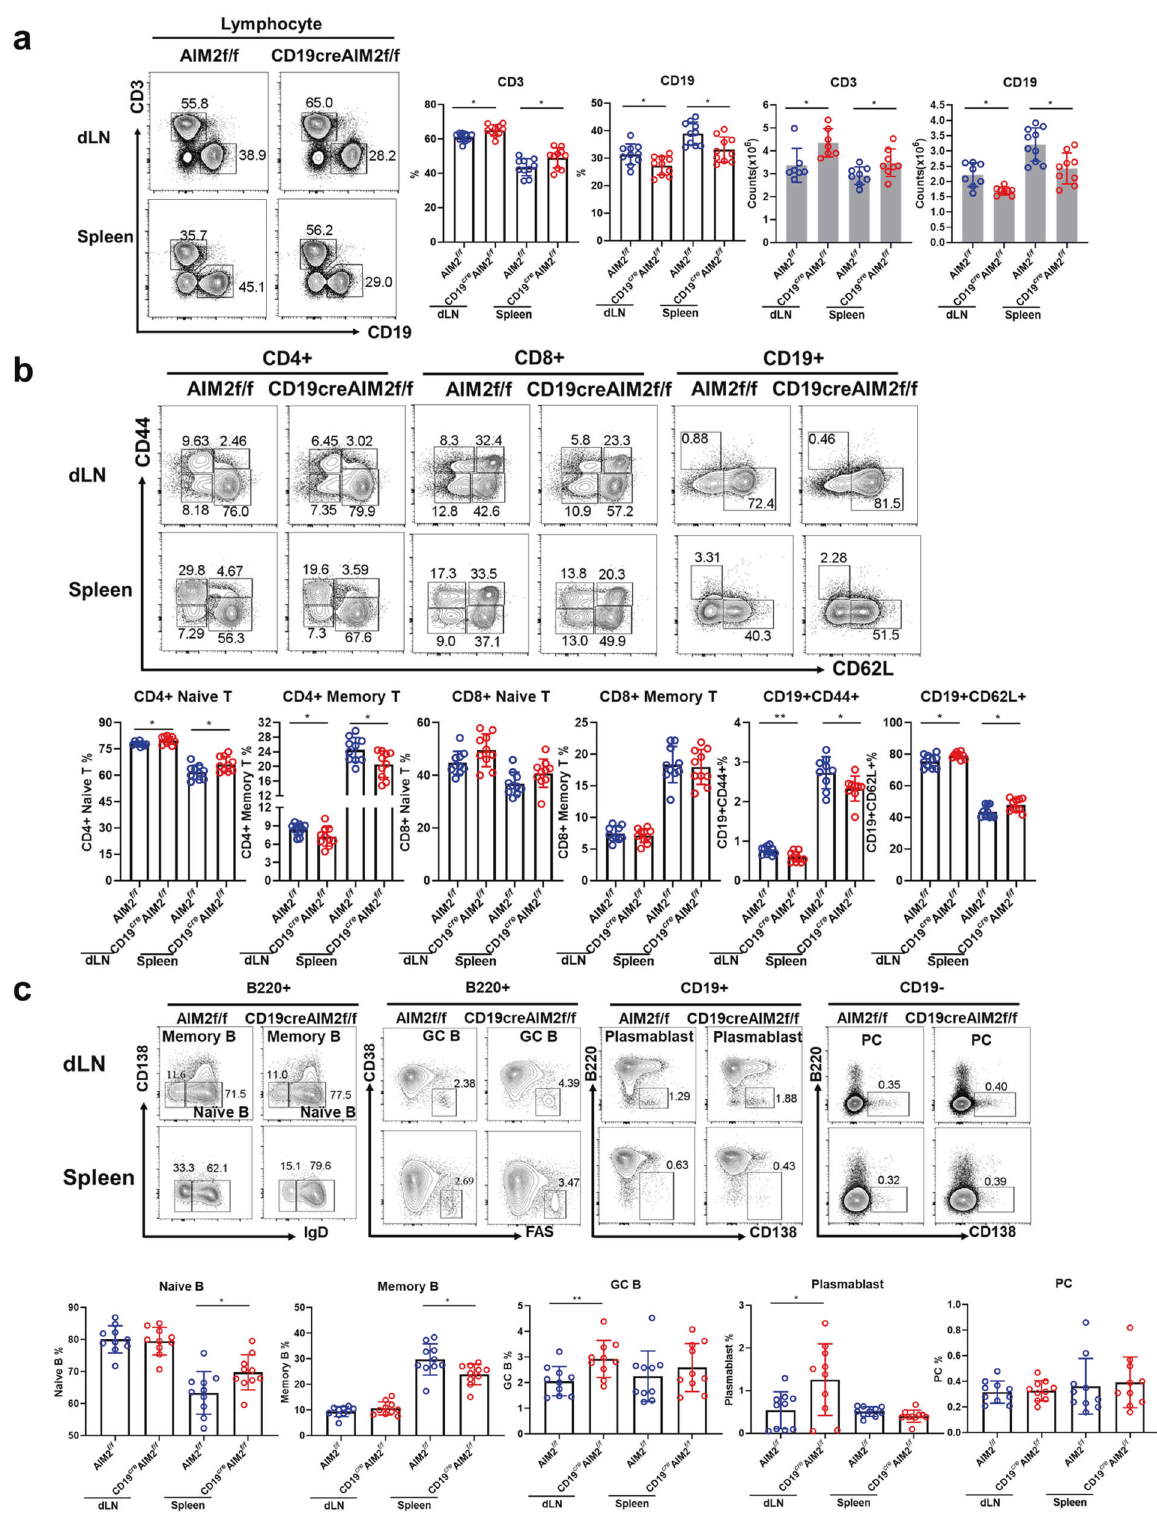
Fig. 2 The phenotype of CD19 cre AIM2 f/f mice. The expression of cell-speci fi c surface markers was detected by fl ow cytometry. a Representative fl ow diagrams and statistical analysis of the percentages of CD3 + , CD19 + cells in the draining lymph nodes (dLNs) and spleens from CD19 cre AIM2 f/f mice and AIM2 f/f mice. b Representative fl ow cytometry diagrams and statistical analysis of CD4 + naive T cells, CD4 + memory T cells, CD8 + naive T cells, CD8 + memory T cells, CD19 + CD44 + B cells, and CD19 + CD62L + B cells. c Representative fl ow cytometry diagrams and statistical analysis of naive B cells, memory B cells, plasmablast cells, plasma cells, GC B cells. Horizontal bars represent the mean ± SEM. * p < 0.05, ** p < 0.01